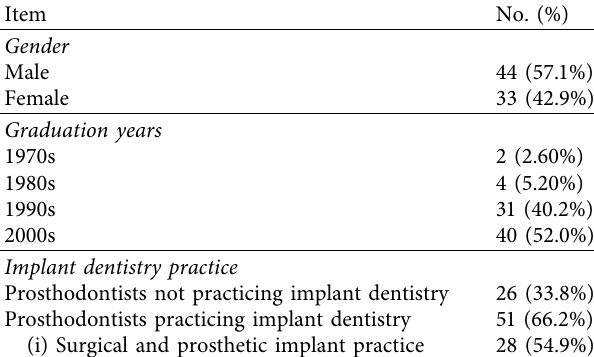
Table 1: Demographic details of